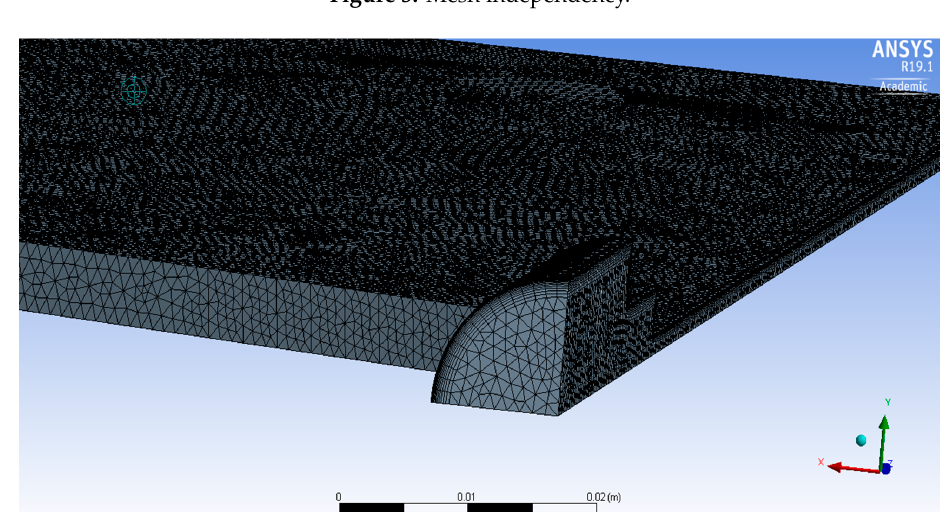
Figure 4. Sample grid used for the simulation.